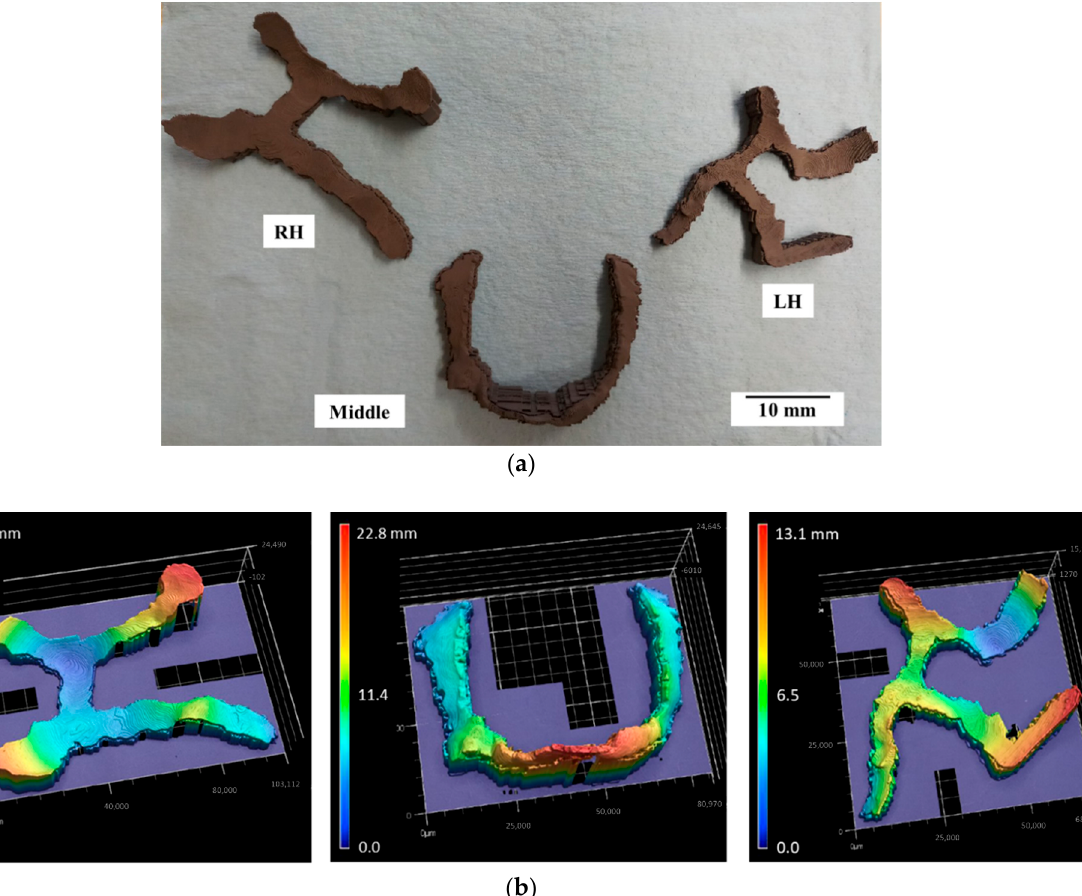
Figure 5. ( a ) Green parts with a support structure; ( b ) optical surface profilometry of maxillofacial implants.